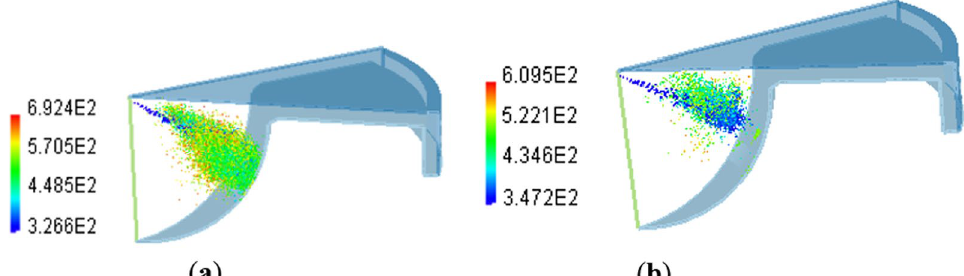
Fig. 19 Spray development of a diesel fuel and b biodiesel